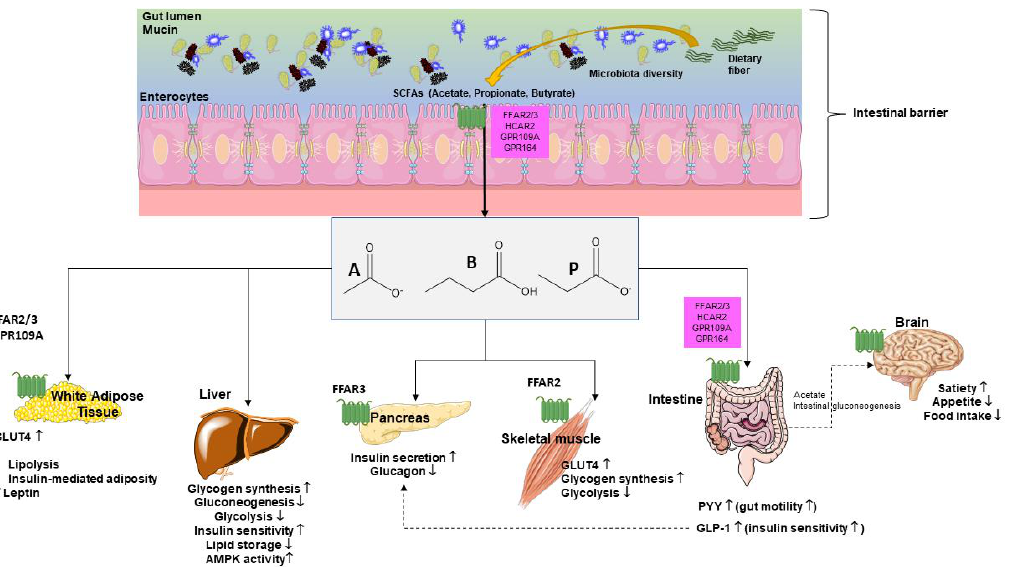
Figure 4. Glucose metabolism is influenced by short chain fatty acids (SCFAs), systemically, at various levels [120]. Main target organs include adipocytes, liver, pancreas, skeletal muscle, intestine, and brain where pathways govern mechanisms, which include receptors, synthesis, hormones, and perception. Abbreviations: GLP-1 — glucagon-like peptide-1; GLUT-4 — activated glucose transporter protein-4; GPR — G-protein-coupled receptors; PYY — peptide YY; A — acetate; P — propionate; B — butyrate.